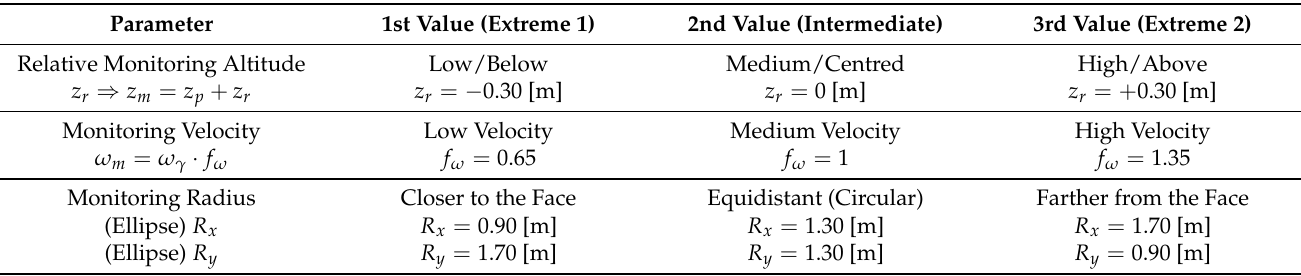
Table 3. Values established in the simulation tests for each of the parameters under study; relative monitoring altitude, monitoring velocity, and monitoring radius (type/shape of trajectory).